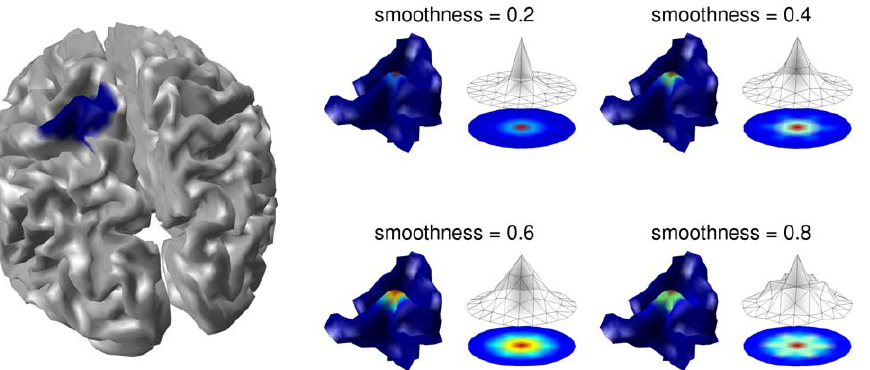
Figure 2. Profile intensities G( s ) of the same spatial pattern for different values of the smoothness parameter s. LEFT: the location and maximum extent of the spatial pattern is shown (blue region). RIGHT: the spatial pattern is shown for different s values ranging from 0.2 to 0.8, projected on the cortical surface (left) and on a flattened surface upon a wireframe height map (right). The number of points featuring more than 60% of the G peak value (central point of the spatial pattern) can range from 20 ( s =0.2) to 55 ( s =0.8).